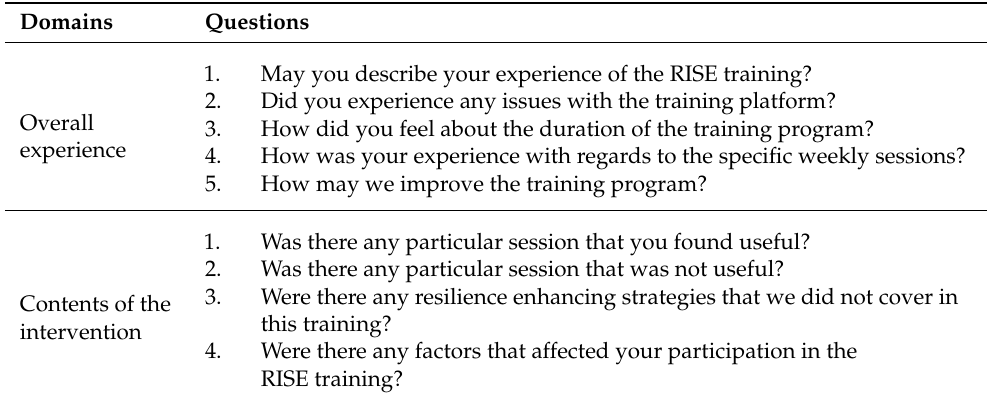
Table 2. Semi-structured interview